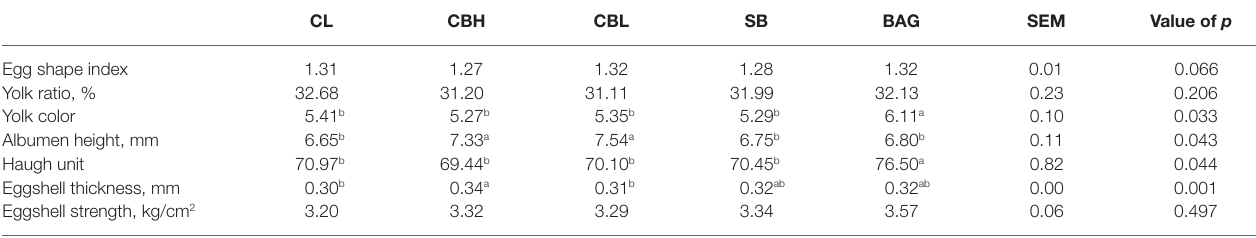
TABLE 3 | Egg quality of yellow-feathered breeder hens.